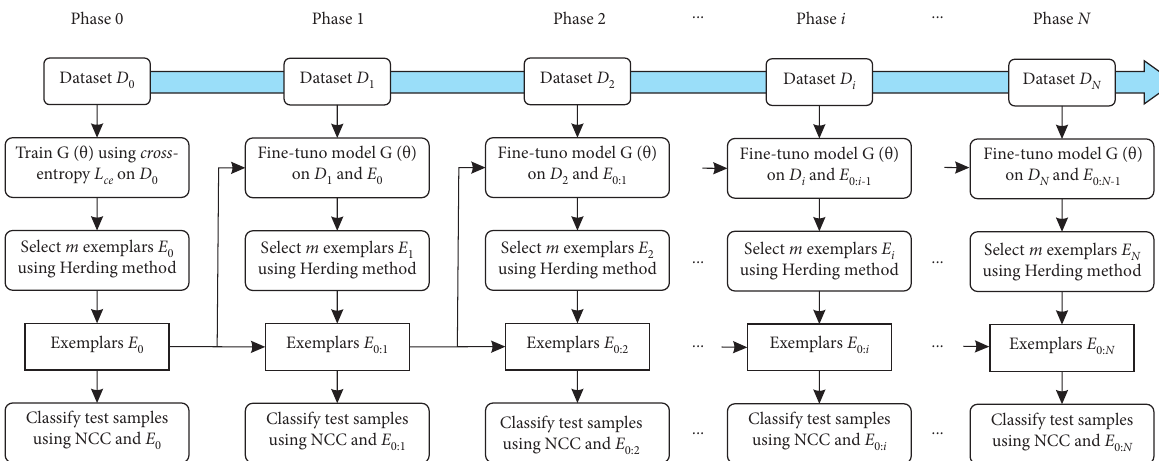
Figure 1: Flowchart of the presented methodology in order to train an incremental classifier for the fault detection in IMs.